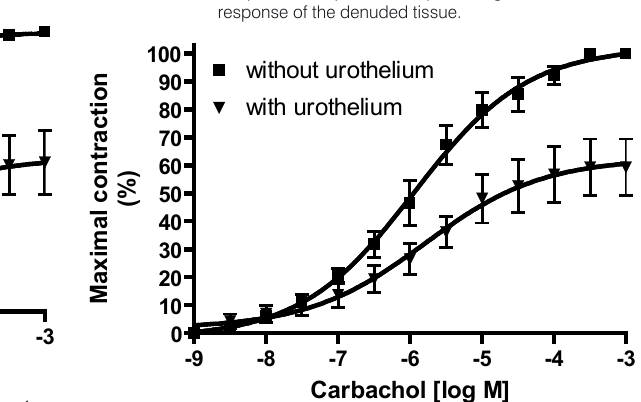
Figure 4. Responses to carbachol of detrusor strips with an intact urothelium or with the urothelium removed after L-NNA (10µM) and indomethacin (5µM) administration. Responses are plotted as a percentage of the maximum response of the denuded